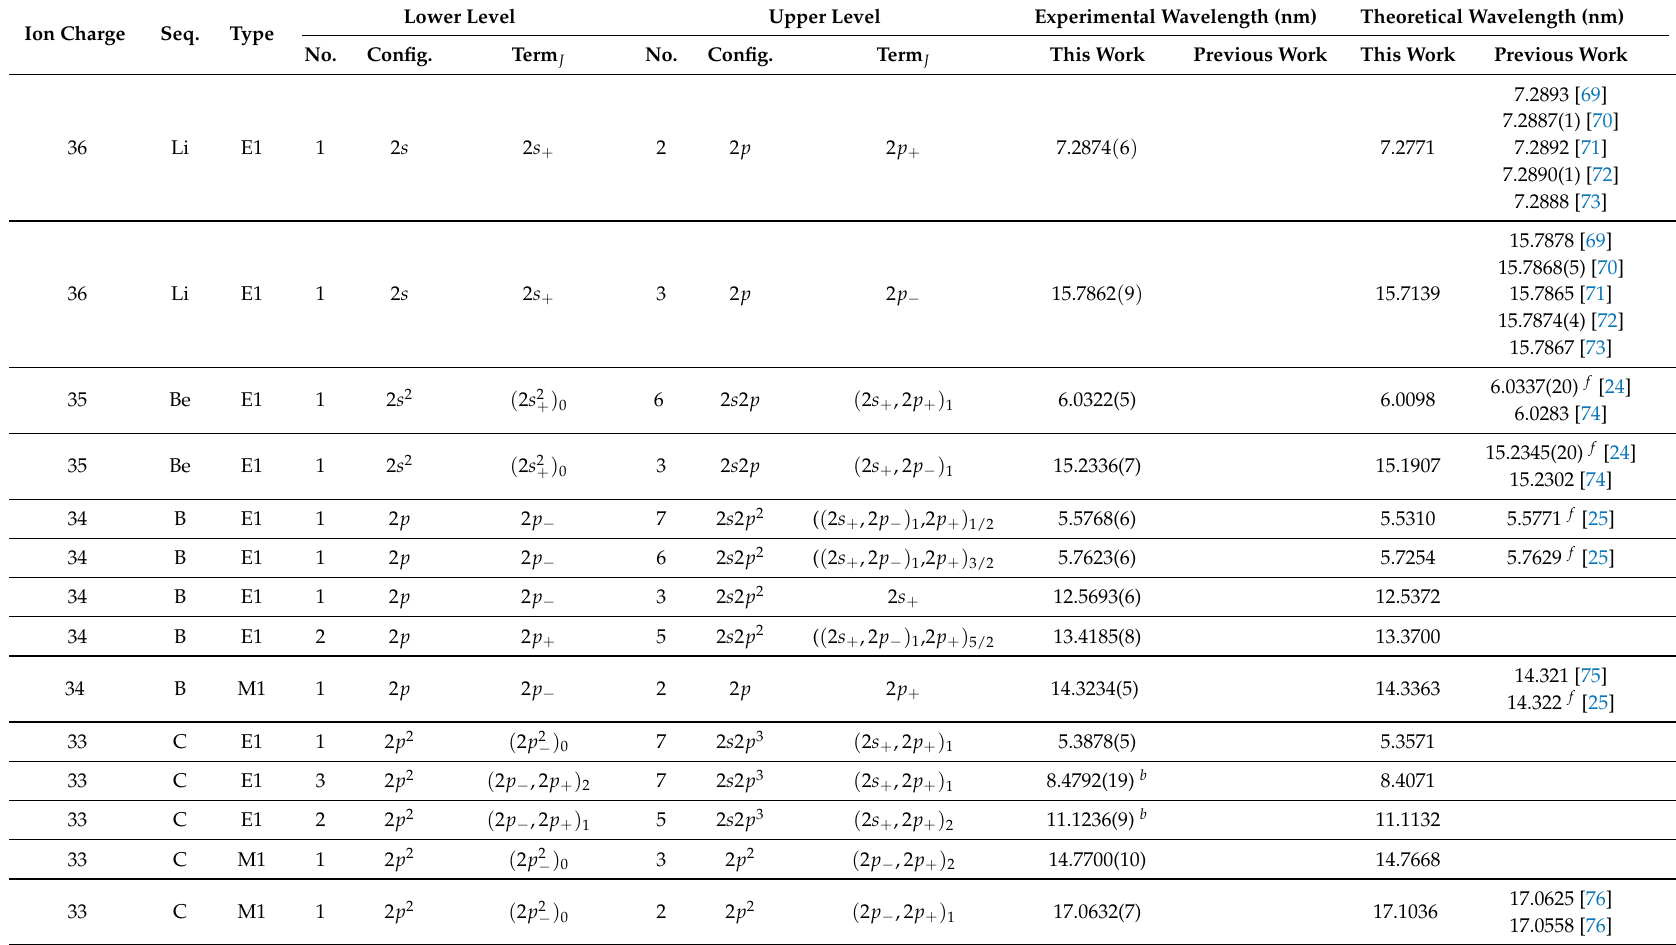
Table 1. The table below presents the list of the yttrium lines identified Y 26 + –Y 36 + . Previous measurements and calculations are reported as well. Isoelectronic sequence is abbreviated as Seq., configuration is abbreviated as Config., and the level number is abbreviated as